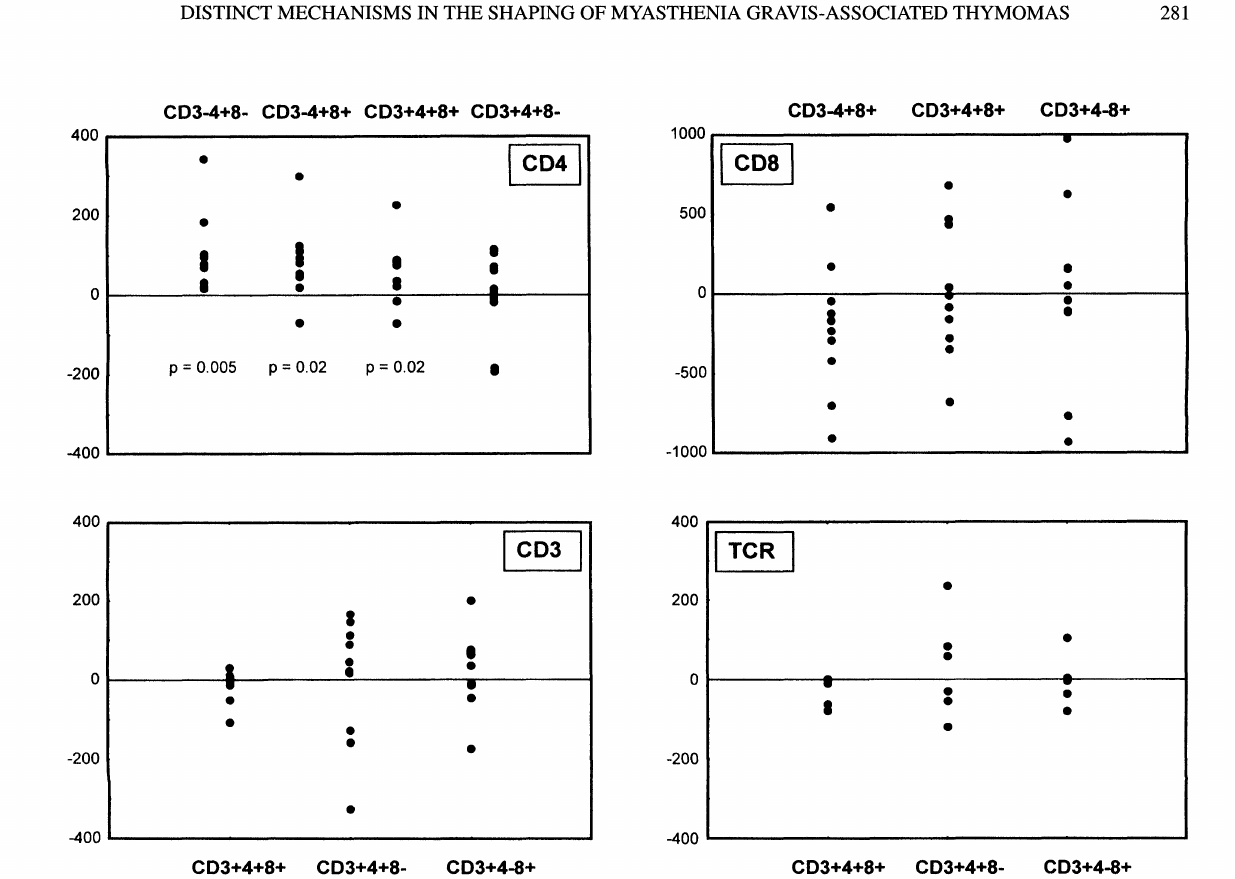
FIGURE Intrapersonal comparison of median surface expression levels of CD4, CD8, CD3 and T cell receptor otl at different stages of thymocyte maturation in thymomas (flow cytometry). Dots indicate the difference between the value of the thymoma and the residual thy- mus of one individual patient. (4 mixed and 8 cortical thymomas well differentiated carcinomas, 12 residual thymuses). As there were no statistically significant differences between mixed and cortical thymomas, all tumors were compared to the residual thymuses. In thymomas, surface CD4 was significantly increased on immature, pre-selective thymocytes, while there was no alteration in the surface expression of CD8, CD3 and the ct[ T cell receptor